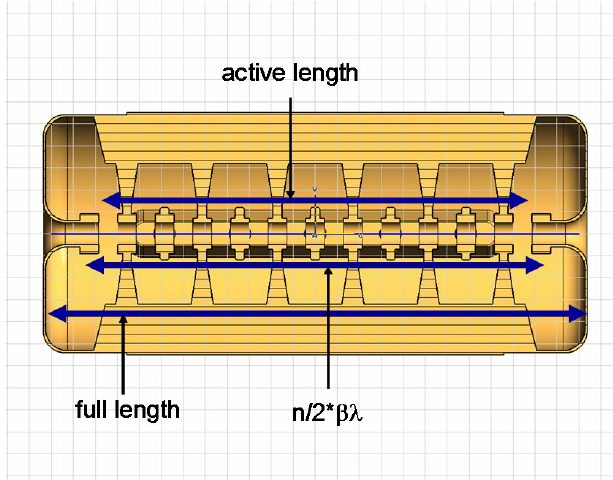
FIG. 32. (Color) The intrinsic Q -value as a function of the effective accelerating gradient based on the (cid:1)(cid:2) definition.